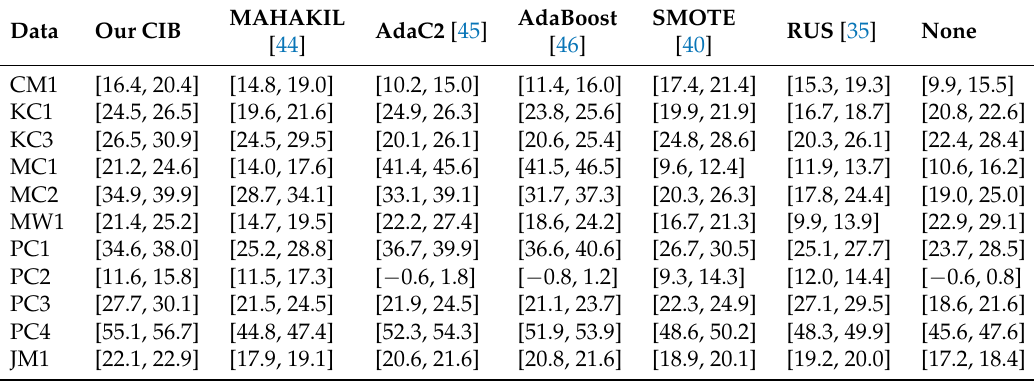
Table 10. 95% confidence interval of MCC for CIB and the baselines on 11 NASA datasets.